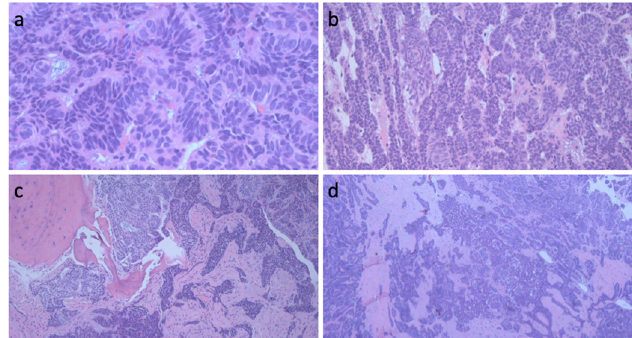
Fig. 1. Histological section of the biopsy showing cells with elongated nuclei assuming a palissadic appearance with clari fi ed cells having an inverted nuclear polarity. The nuclei are the site of clear-cut nuclear atypia, and mitotic fi gures are visible. (a) Magni fi cation (cid:3) 50, (b) Magni fi cation (cid:3) 100, (c) Magni fi cation (cid:3) 200, (d) Magni fi cation (cid:3) 400.